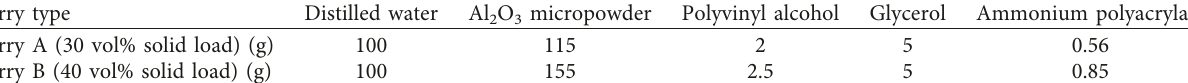
Table 4: Formulation of two ceramic slurries with different Al